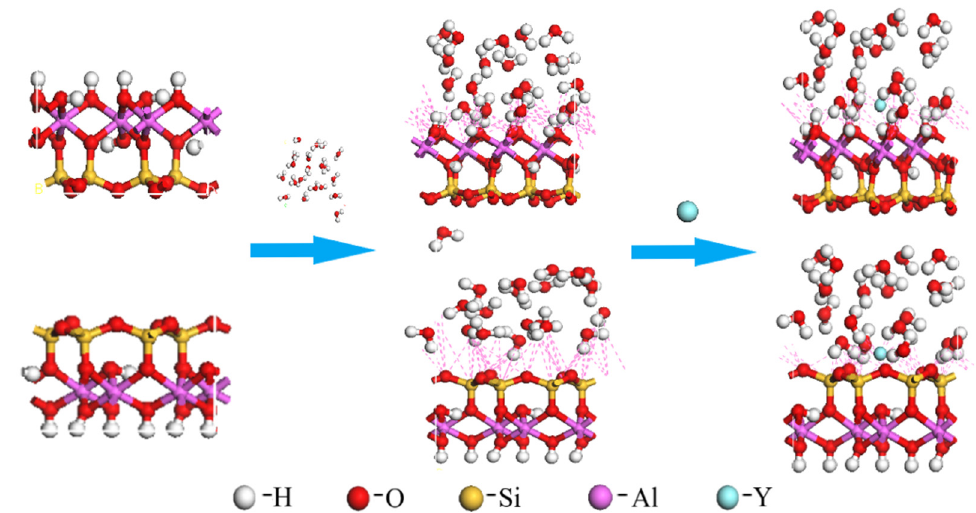
Figure 1. Construction of interface adsorption model of kaolinite-H 2 O.